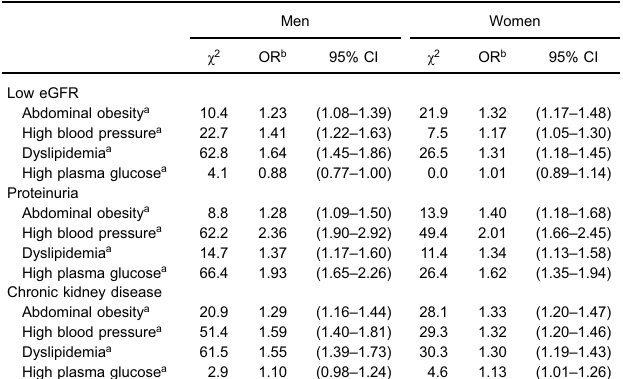
Table 2. Odds ratios of the presence of low eGFR, proteinuria, and chronic kidney disease for abdominal obesity and metabolic abnormalities in Japanese men and